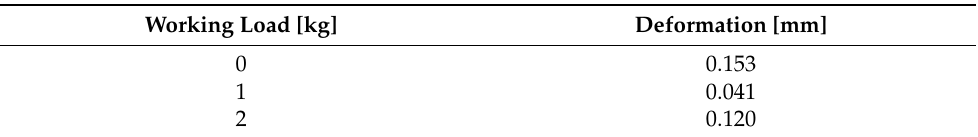
Table 4. Size of deformation in the direction of axis Z for CvM_NcM, determined by experimental measurement.